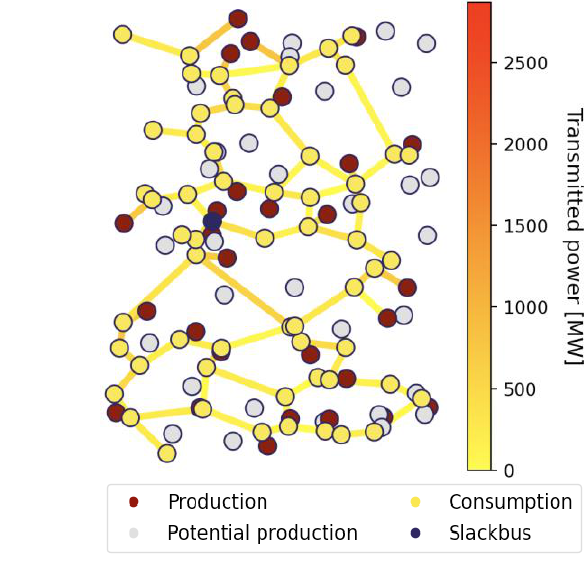
Figure 2. Wind production scenario with a rectangular map area: ( a ) With the base case; ( b ) Refer- ence case when the distance-based value loss was 20%/1000 km.